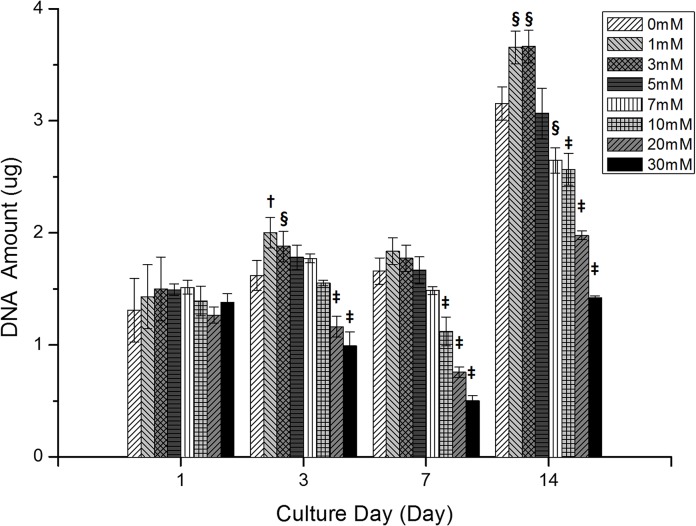
Graphical illustration of changes in DNA levels (cell proliferation) at days 1, 3, 7 and 14 with various TSP concentrations (0, 1, 3, 4, 7, 10, 20 and 30 mM) by DNA assay (n = 10).Symbols indicate significant differences in comparison with the TSP-free (0 mM) specimen (§: p<0.02, †: p<0.01, ‡:p<0.001).